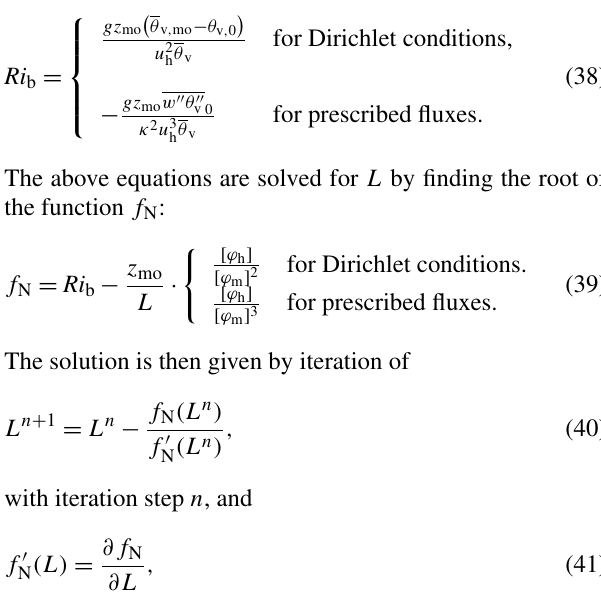
Table 4. List of surface layer